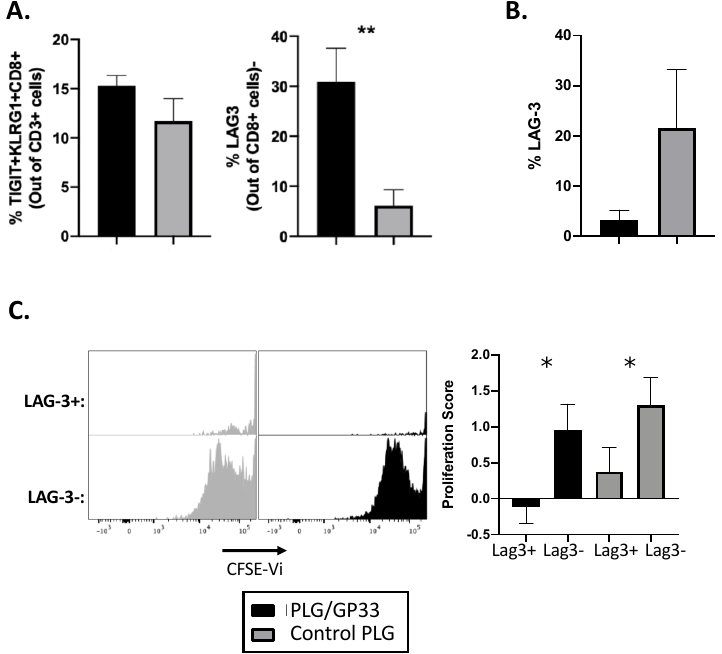
Figure 5. Antigen-encapsulating PLG/GP33 nanoparticles induce partial exhaustion in GP33-specific CD8 + T cell. Female P14 mice ( n = 3 – 4) were injected intravenously with either PLG/GP33 or a control PLG (PLG/OVA323 or PLG). Spleens and/or lymph nodes (pooled axillary, brachial, and inguinal) were harvested and counted 3 days later. Viable T cells were analyzed by flow cytometry.